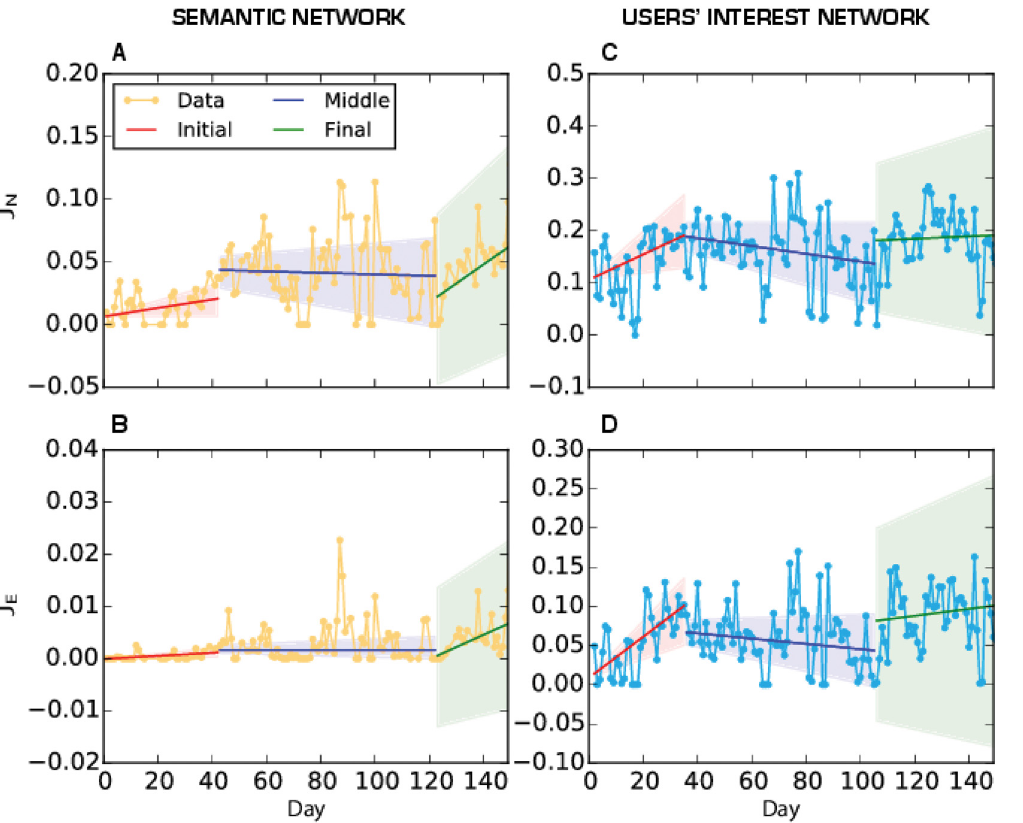
Fig 5. Time series for the Jaccard index for the two networks: semantic on the left, users ’ interest on the right. For each of the three phases(Initial, Middle and Final) we have estimated the interpolating lines using Theil-Sen regression and the shaded area correspond on the 95% Confidence Interval. Figures A and C: dots represent the values of the Jaccard index for the Nodes at time t and at time t-1 . Figure B and D: dots and line represent the values of the Jaccard index between the set of edges of the at time t and at time t-1